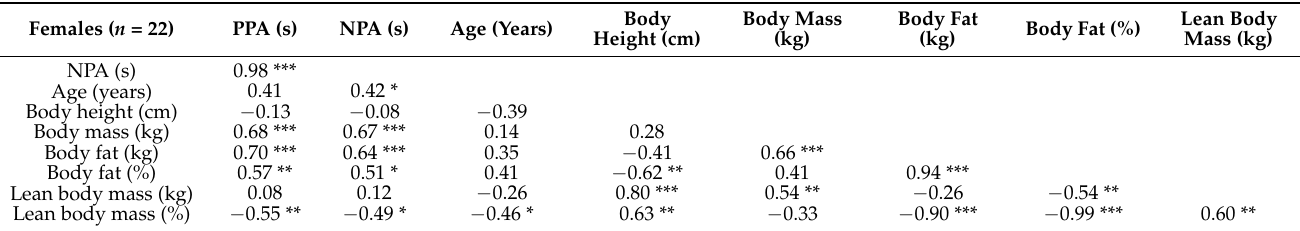
Table 5. Pearson’s correlation coefficients between studied variables for female